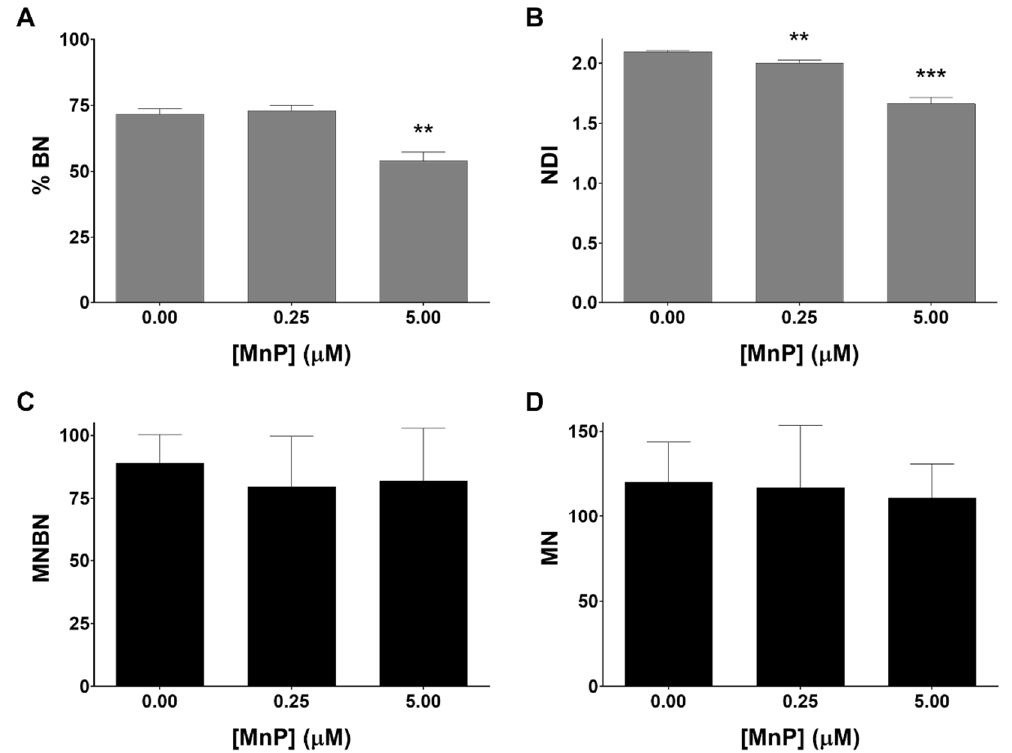
Figure 5. The effects of MnP on proliferative indices ( A and B ) and induction of micronuclei ( C and D ) in 786-O cells evaluated by the cytokinesis-block micronucleus (CBMN) assay. Percentage of binucleated cells (% BN) ( A ), nuclear division index (NDI) ( B ), frequency of micronucleated binucleated cells (MNBN) in 1000 BN cells ( C ) and a total number of micronuclei (MN) in 1000 BN cells ( D ) are shown. Values represent mean ± SD (n = 3), ** p < 0.01 and *** p < 0.001 (Student’s t-test).